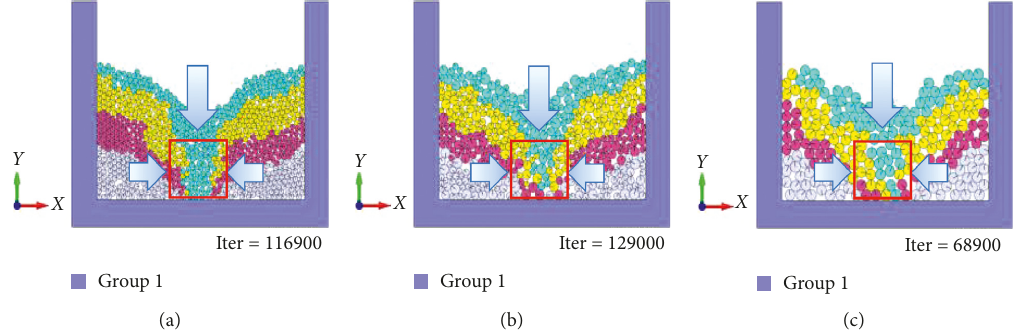
Figure 8: Collapsed process of excavation of the lower central lower part of coal particles with different particle sizes. (a) Coal particles of 0.1m particle size. (b) Coal particles of 0.1–0.2 m particle size. (c) Coal particles of 0.2m particle